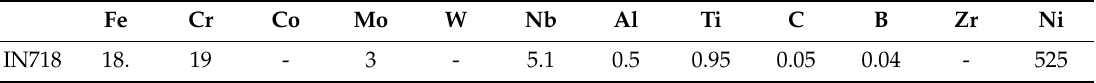
Table 1. Chemical composition of the Inconel 718 alloy in% of